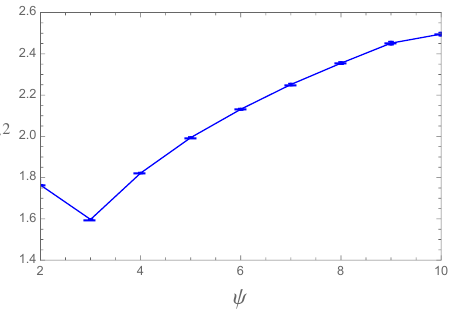
Figure 4 . The same data as presented in (cid:12)gure 3 with the large features associated to the conifold points omitted from the plot range. The tendency towards a hierarchy of scales between that set by the overall volume and that by highest value of the second order curvature invariant as the large complex structure limit is approached can clearly be seen.